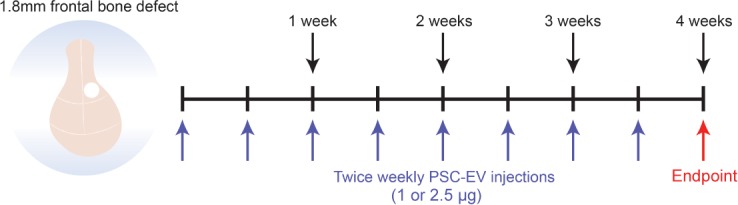
Animal treatment protocol.Schematic representation of animal treatment protocol for in vivo study. A full-thickness frontal bone defect is created (1.8 mm diameter circular defect in the right frontal bone), followed by percutaneous treatment with PSC-EV (twice weekly for a four week period). The study endpoint was after 4 weeks, at which time postmortem studies were performed.